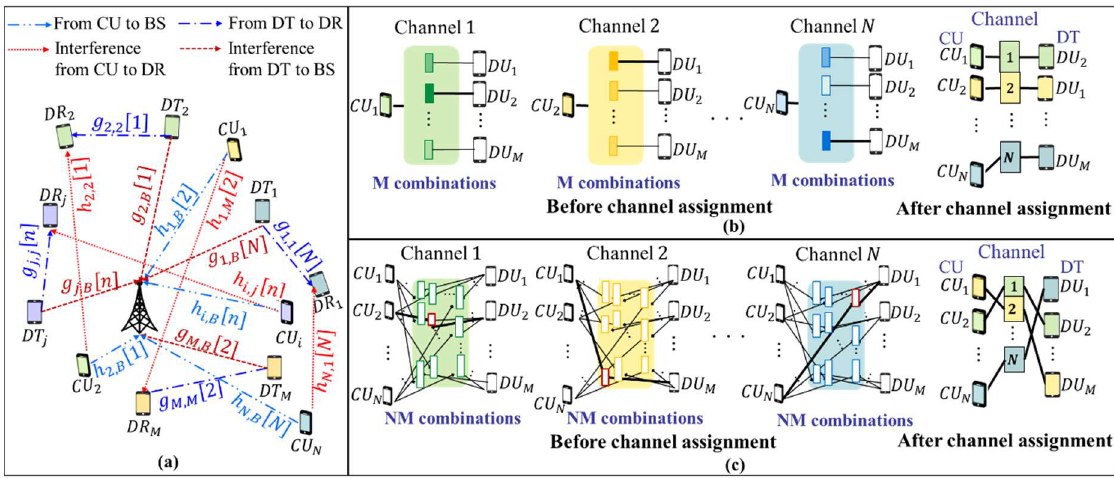
Figure 1. A D2D underlaid cellular networks and two illustrative examples of the channel assignment. ( a ) System model, ( b ) channel assignment when each channel is pre-assigned to a cellular UE (CU), ( c ) proposed 3-D channel assignment.